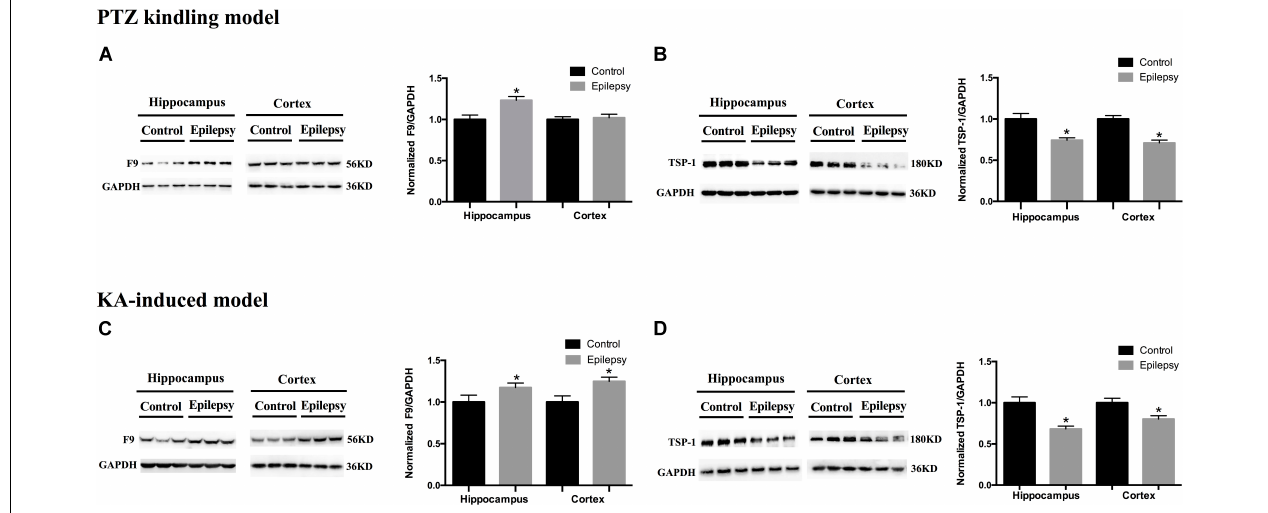
FIGURE 7 | Expression of F9 and TSP-1 in brain tissue exosomes from epileptic mice. (A) In the PTZ-kindling epilepsy model exosomal F9 protein was expressed at higher levels in the hippocampus of epileptic mice than in that of control mice ( n = 5 in each group, ∗ P < 0.05), but there were no significant differences in the levels in the cortex. (C) In the KA-induced epilepsy model exosomal F9 protein was expressed at higher levels in the cortex and hippocampus of epileptic mice than in those of control mice ( n = 5 in each group, ∗ P < 0.05). In the PTZ-kindling epilepsy model (B) and the KA-induced epilepsy model (D) , exosomal TSP-1 protein was expressed at lower levels in the cortex and hippocampus of epileptic mice than in those of control mice ( n = 5 in each group, ∗ P < 0.05). Mean ± SEM Student’s t -test was performed.